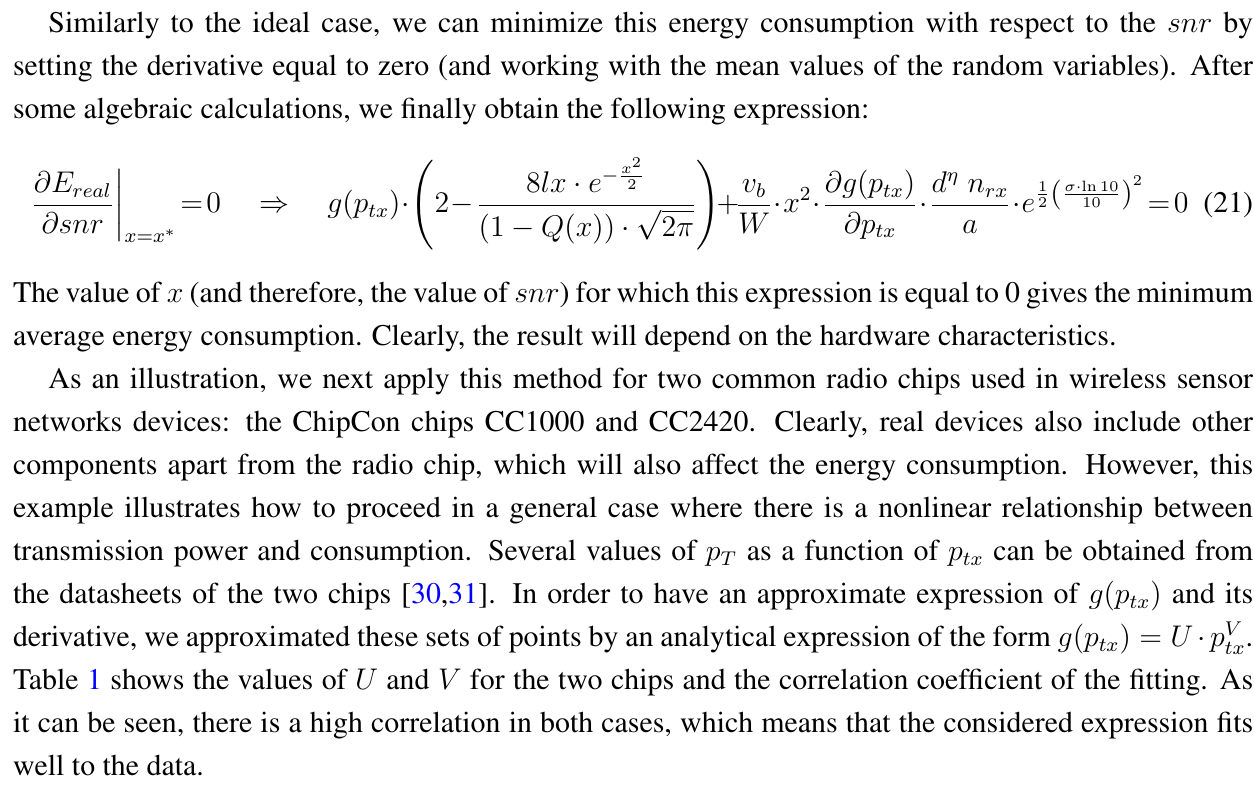
) = p /p for the CC1000 and CC2420 tx T tx